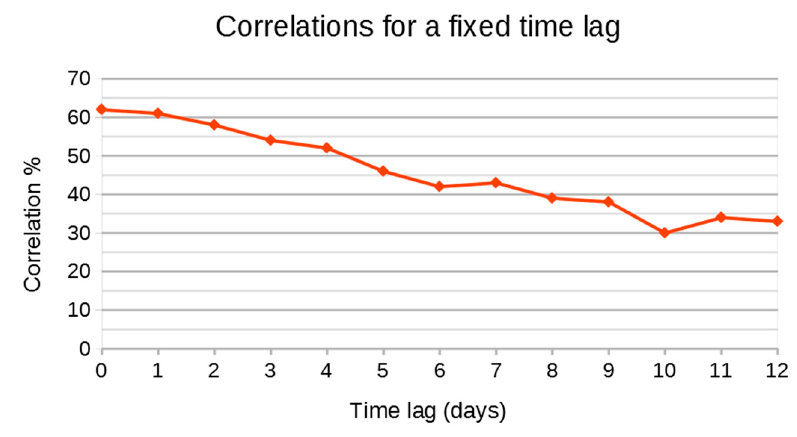
Figure 8. Evolution of the correlation coefficient between Sentinel-2 NDSI and Izas FSC as a function of the time lag.